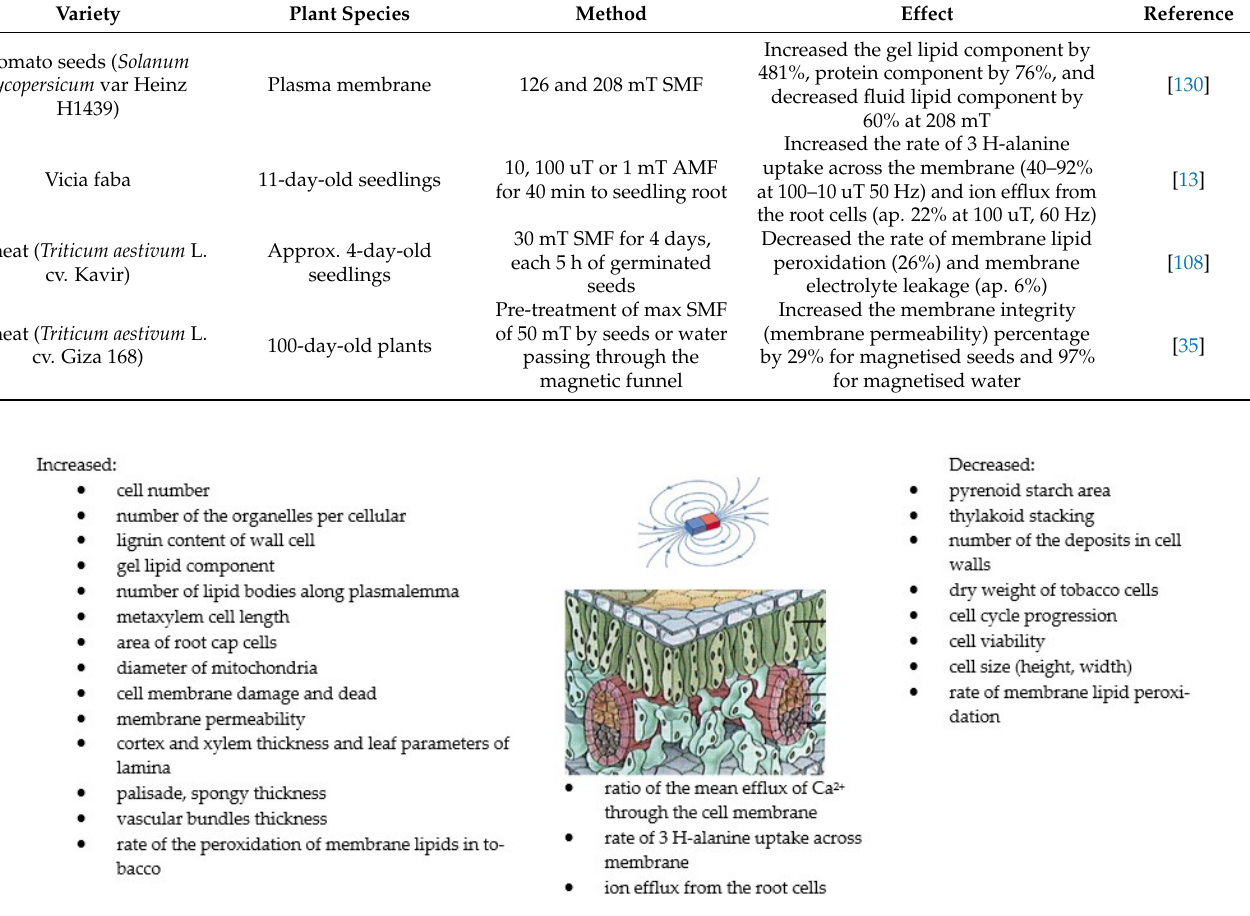
Figure 3. The summary of the effects of MFs on structure and cell growth [13,27,53,124,126]. Copy- right https://brainly.co.id (accessed 23 August 2022). right https://brainly.co.id (accessed 23 August